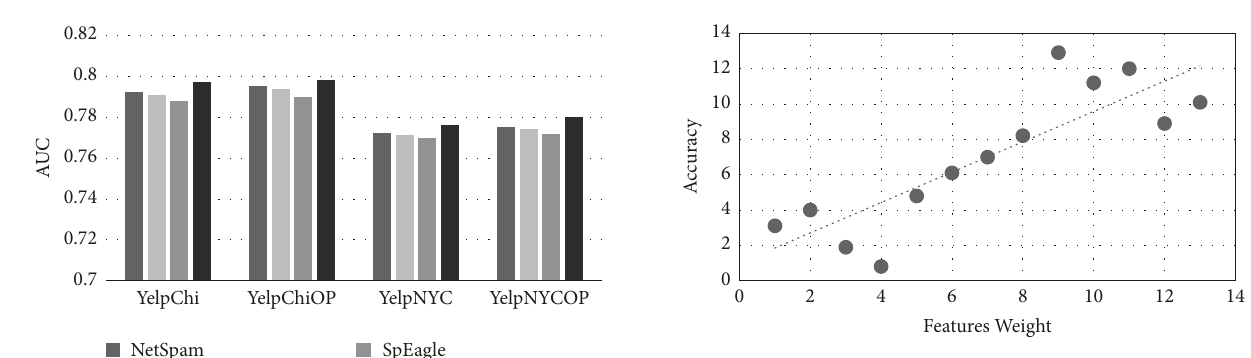
Figure 11: Relationship between features weight and